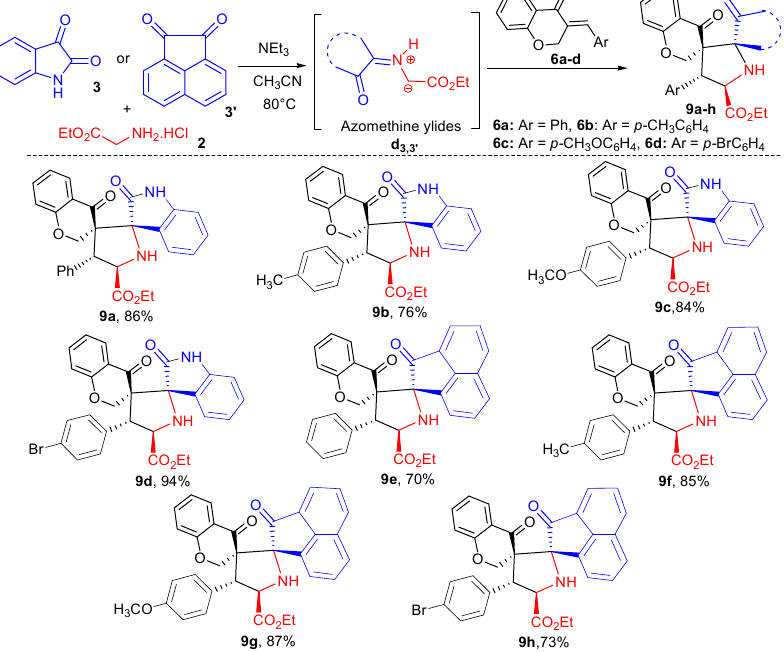
Table 2. Synthesis of acenaphthylen-1(2 H ) - one-spiropyrrolidine-chromanone hybrids 9.